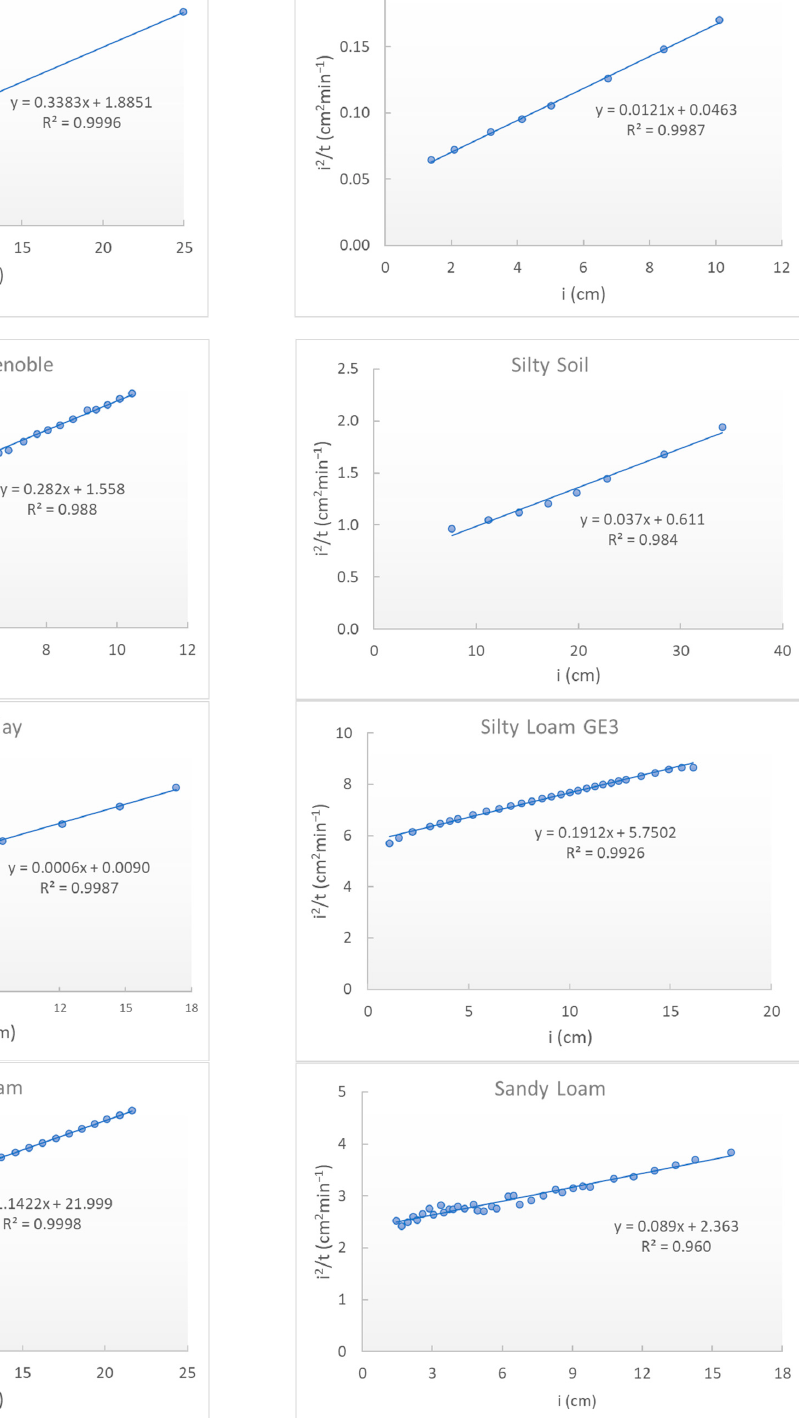
slope of the regression line,